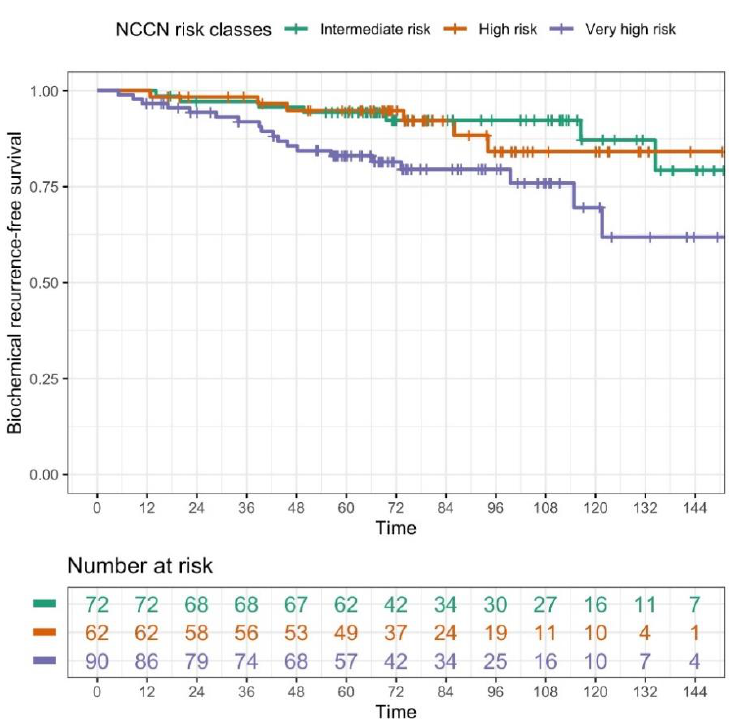
Figure 2. Kaplan–Meier estimates for biochemical relapse-free survival (bRFS) in the three NCCN risk classes ( p = 0.021, log-rank test; NCCN risk class VHR vs. NCCN risk class UIR, HR = 2.7924, 95% CI: 1.1689–6.6705, p = 0.0208, univariate Cox regression model). Although all the data were used for statistical analyses, here, for graphic purposes only, the plot was curtailed at 12 years, since